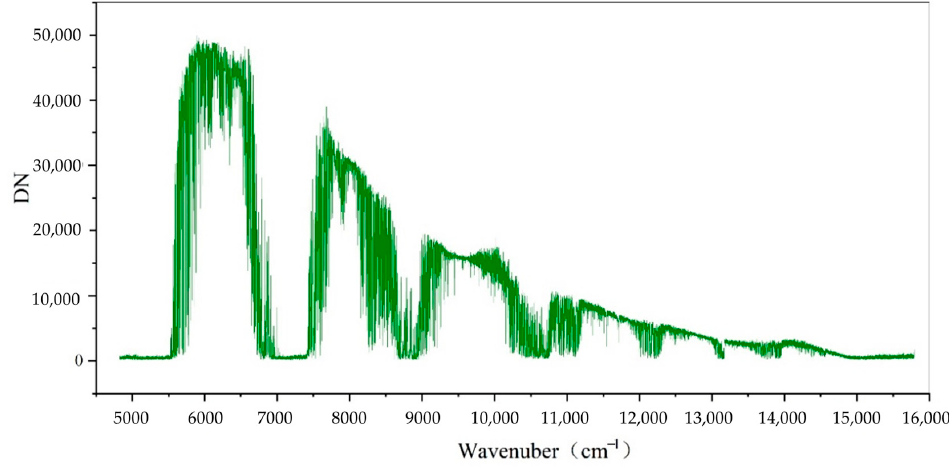
Figure 15. Spectral curve of HRFTS after Fourier transform.